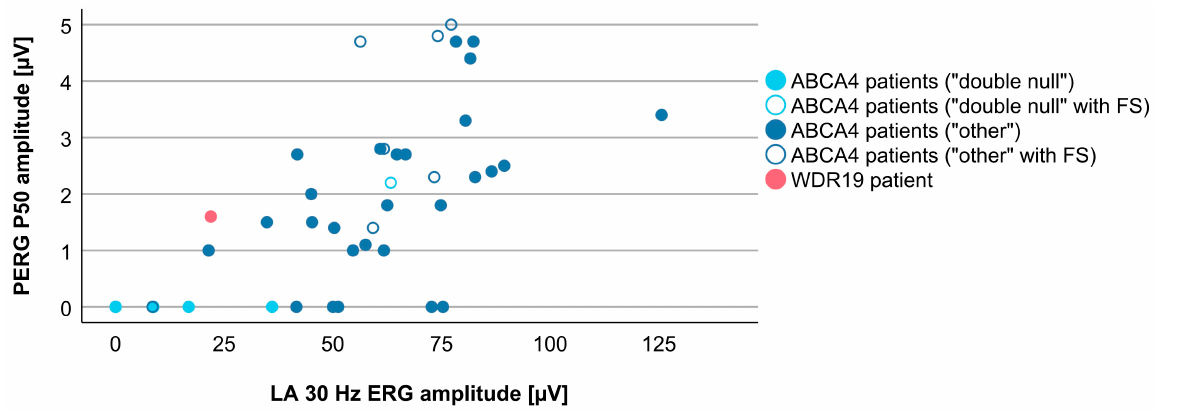
Figure 12. Different ratios of cone system and macular photoreceptors impairment in WDR19 patient (red), double null ABCA4 patients (light blue) and ABCA4 patients with other genotypes (dark blue). Foveal sparing patients are marked with empty circles.